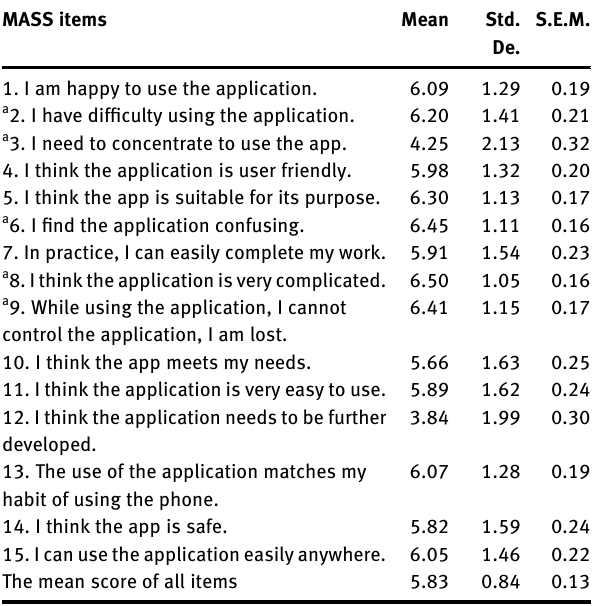
Table  : MASS descriptive analysis